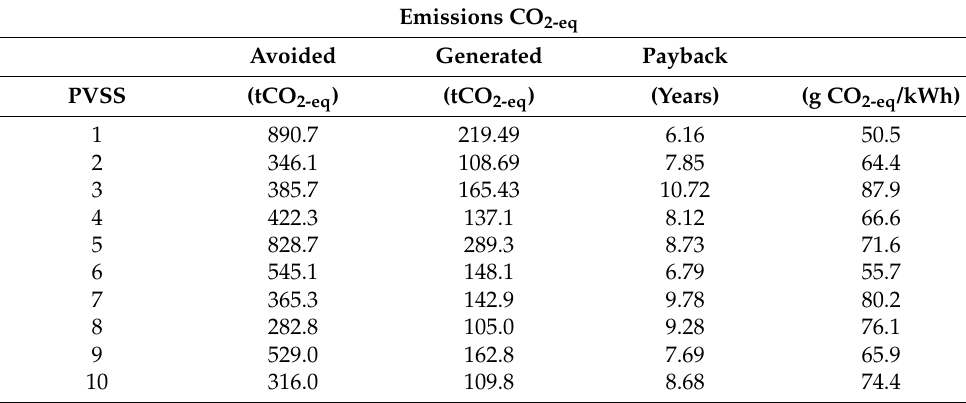
Table 4. Energy payback time and GHGe-rate calculated with the upper range of the factors values. (Factors assumptions